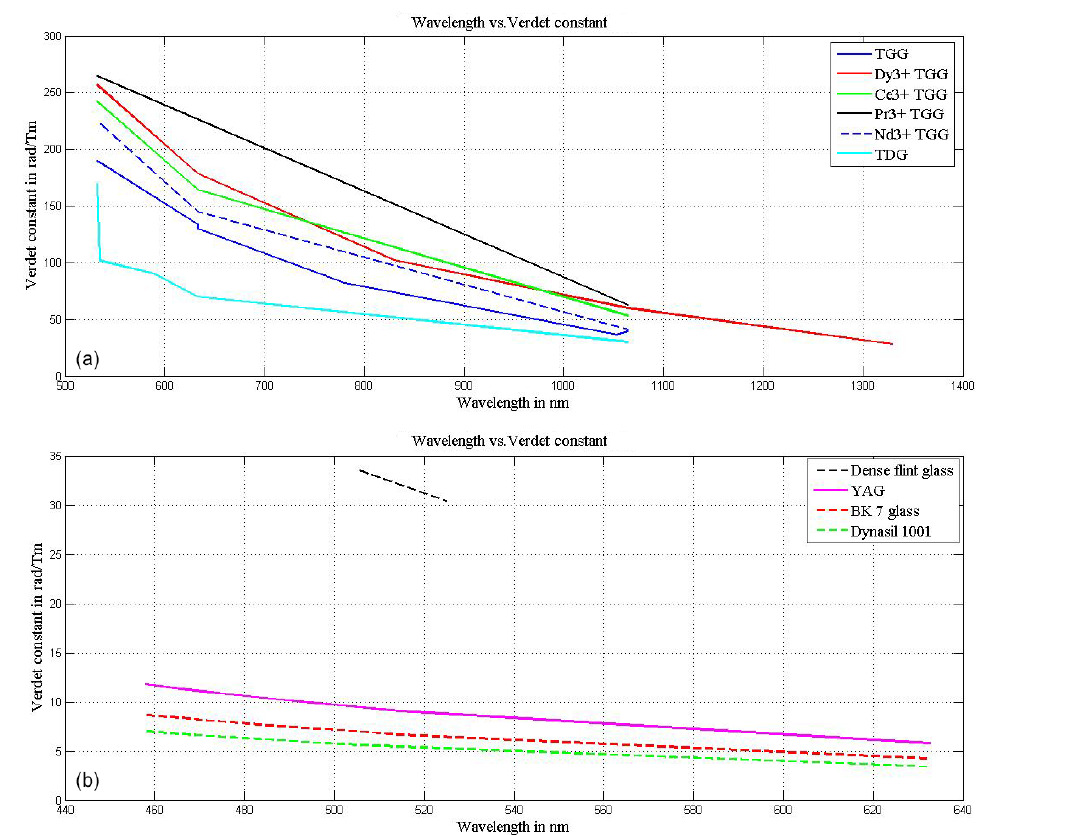
Figure 2. Verdet constant (radTm − 1 ) versus wavelength (nm) plot for (a) paramagnetic and (b) diamagnetic materials.